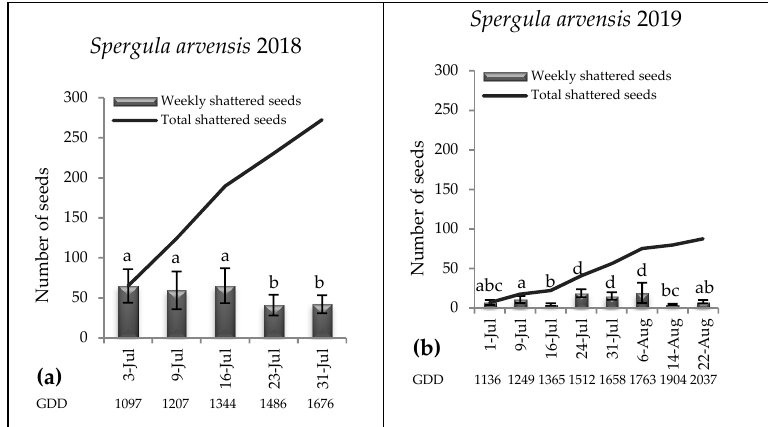
Figure 5. Average weekly and cumulative seed shedding per plant of Spergula arvensis in ( a ) 2018 and ( b ) 2019 during the growing season of spring oat. GDD = Growth Degree Days = sum of daily mean temperatures above 0 from the date the oat was sown . Columns with different letters are statistically different at the 0.05 probability level.